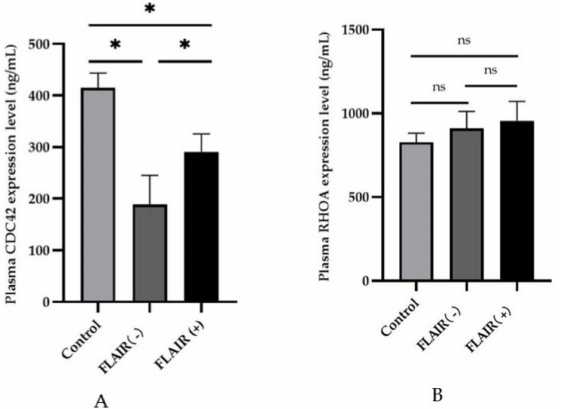
Figure 4. Plasma CDC42 and RHOA expression levels in the control, FLAIR ( − ), and FLAIR (+) groups. ( A ) Plasma CDC42 expression in each group. * Presented p < 0.05. ( B ) Plasma RHOA expression in each group. ns, p >